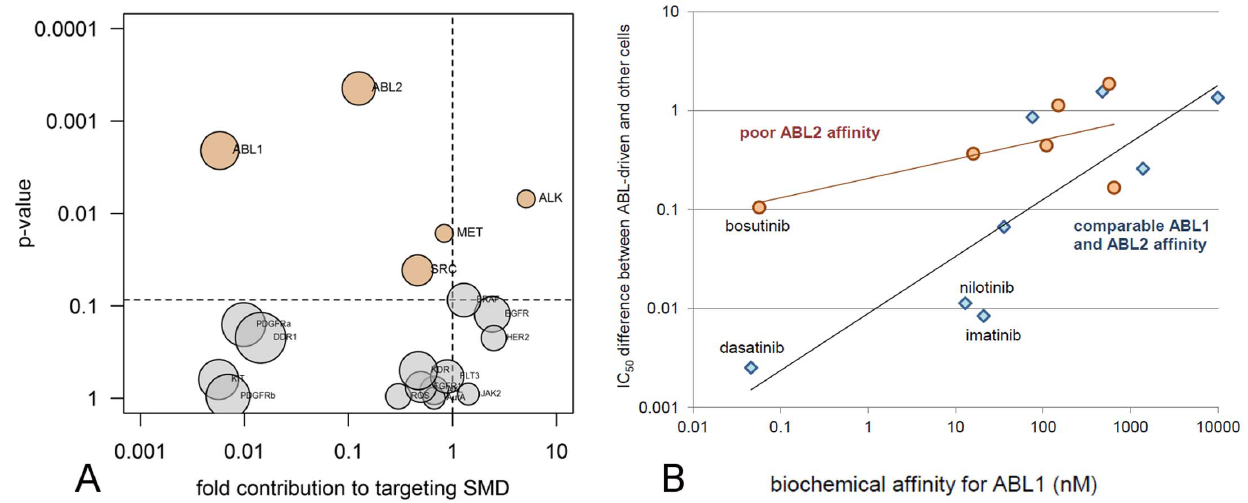
Figure 6. Determining the optimal kinome profile of an ABL inhibitor. A: Biochemical components of kinase inhibitors that contribute to the specific targeting of ABL1 dependent cell growth. The circle labelled ABL1 refers to biochemical ABL1 inhibition. B: Inhibitors with equal ABL1 and ABL2 affinity in an independent dataset [12] are better in targeting ABL1 -dependent cell growth than inhibitors with ABL1 activity alone. Poor ABL2 affinity signifies binding K d differences between 4 and 26-fold compared to ABL1. Equal affinity signifies binding K d differences between 0.5 and 4- fold.